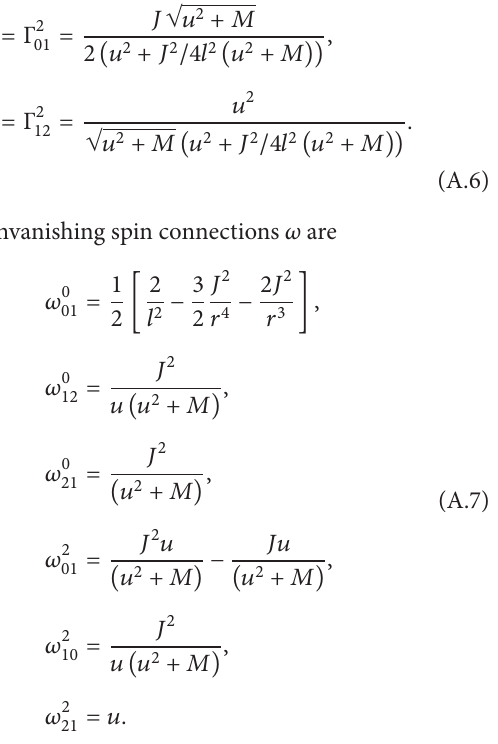
is proportional to 𝜇 and 𝑐 − 1